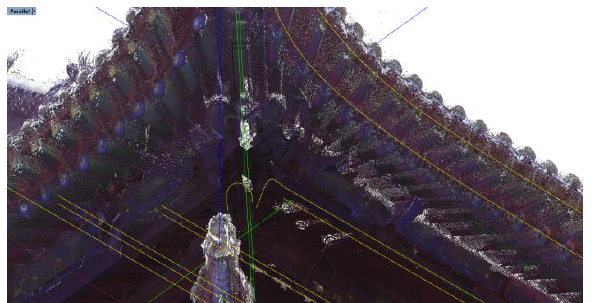
Figure 20. Extracting the skeleton curves by reference to